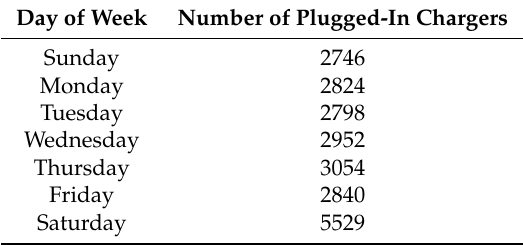
Table 5. Number of the charger plug-ins according to the day of the